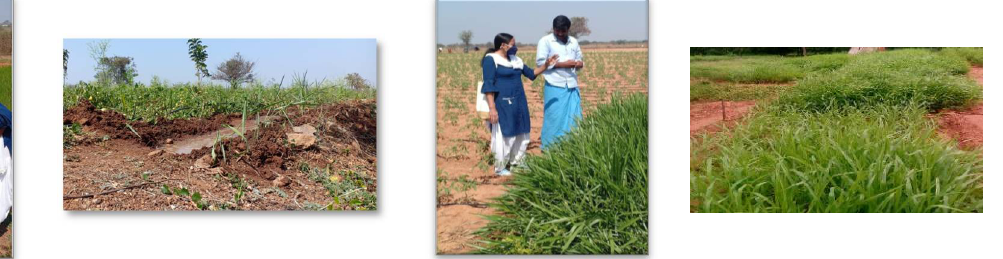
Figure 4. Photos: Planting to harvesting in farmers’ fields.